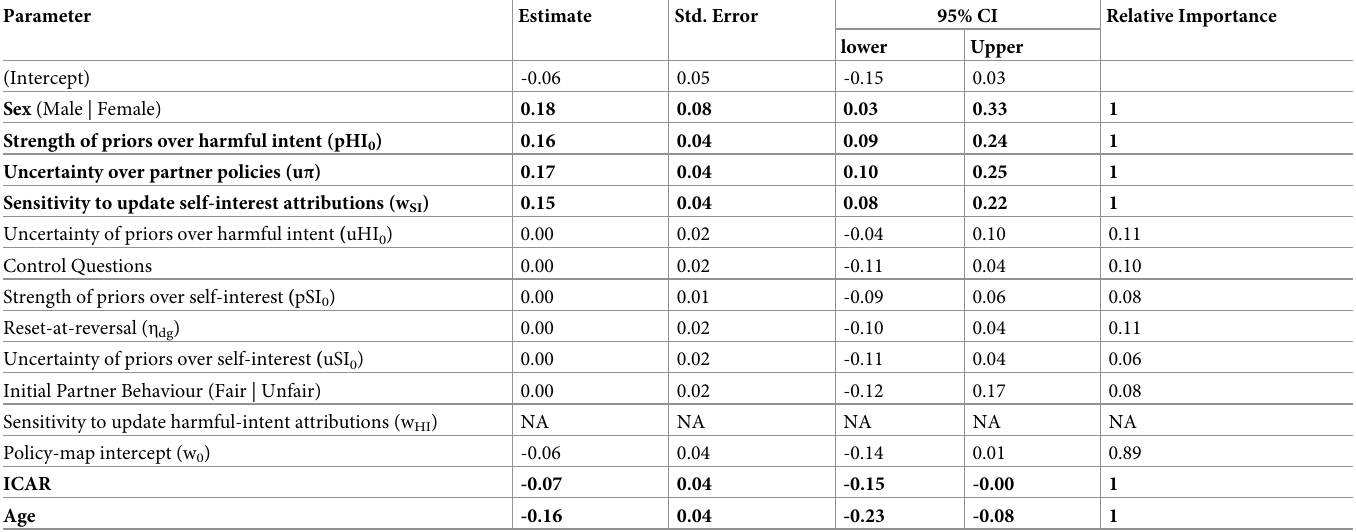
Table 2. Top Model Average of Parameters Associated with Pre-Existing Paranoia in the Modified Repeated Reversal Dictator Game. All regression estimates are extracted from Model S5 in the analysis code. NA indicates that the parameter was not included in the final top